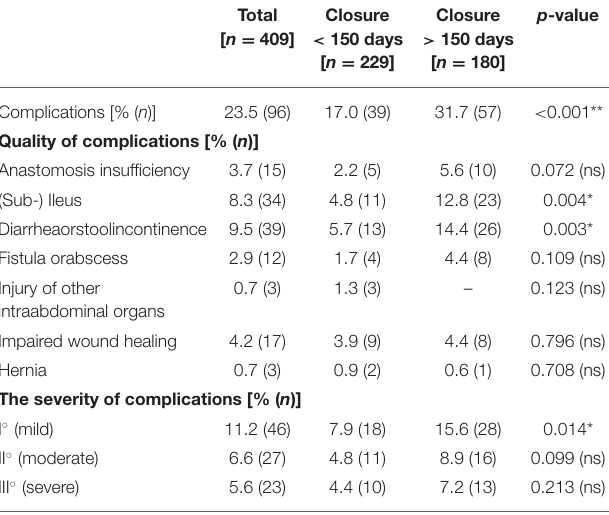
TABLE 1 | Complications after protective loop-ileostomy